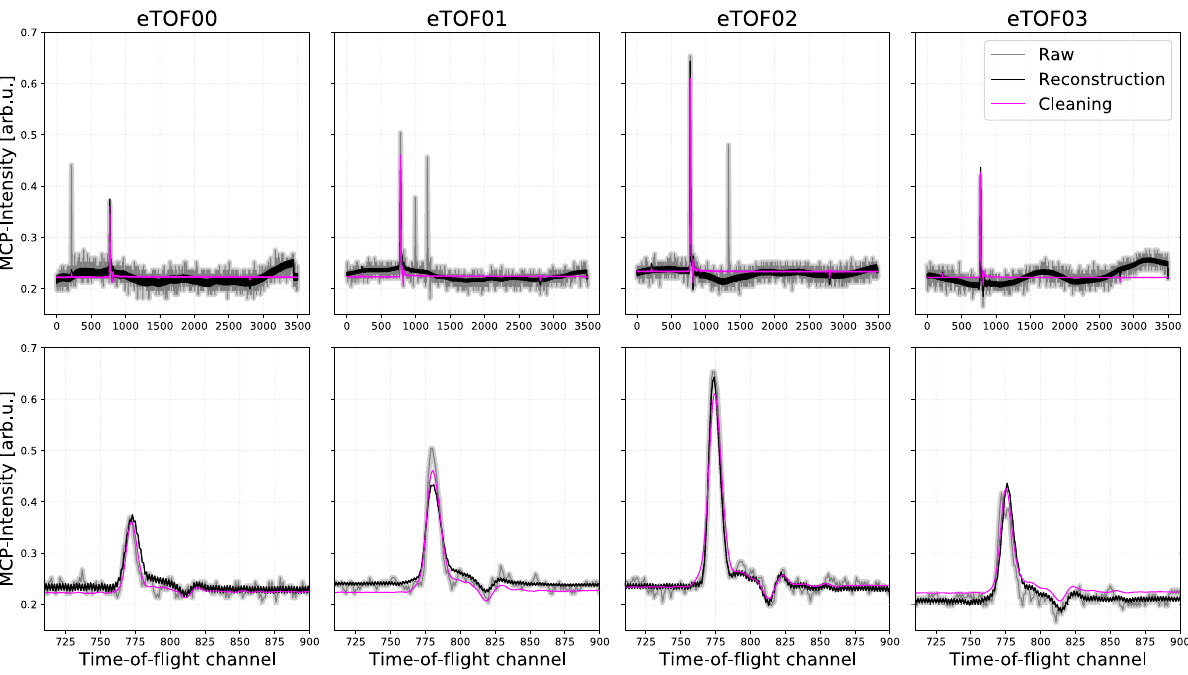
Figure 4. Data cleaning example: The raw data (grey) is reconstructed via the network as shown in black. All random hits are discarded, the noise level is reduced and the prompt signal is reconstructed. A modification of the latent space allows for eliminating the interleaving issue and a removal of the baseline disturbance